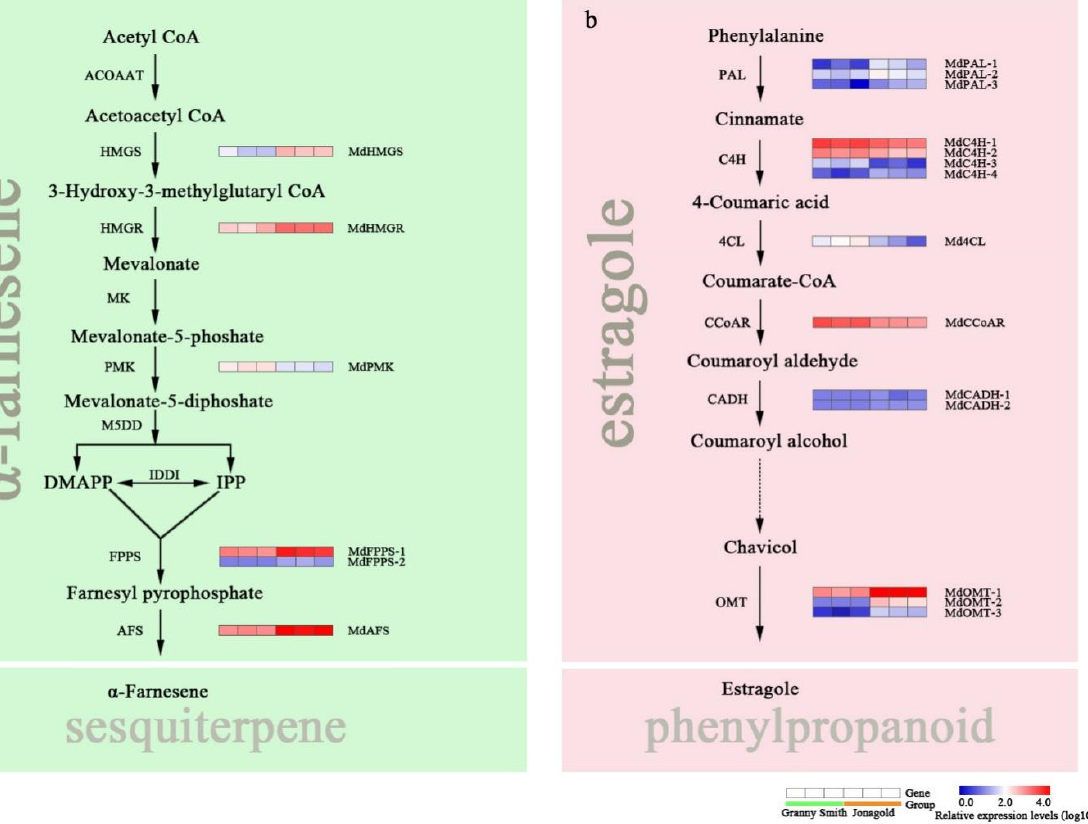
Figure 5. Expression profiles of differentially expressed genes (DEGs) involved in sesquiterpene and phenylpropanoid metabolism pathways between the Granny Smith and Jonagold apples. ( a ) Biosynthetic pathway for α -farnesene. ( b ) Biosynthetic pathway for estragole.